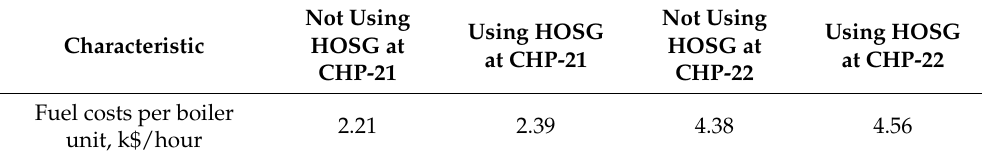
Table 6. Fuel costs of using and not using